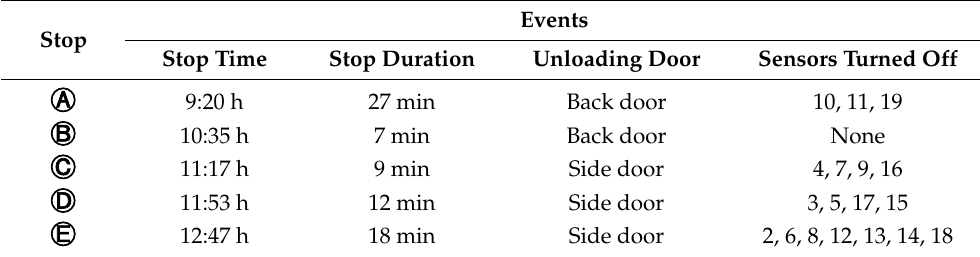
Figure 8. Route stops ( a ) and graphical representation of the duration of those stops ( b ). The route started at a point Ⓞ . At 8:40 h, the van started, and the van’s refrigeration system was turned on. After leaving the warehouse, five more stops were made for un- loading, before returning. Table 3 displays the details about all the unloading stops made. Table 3. Stops and relevant information.